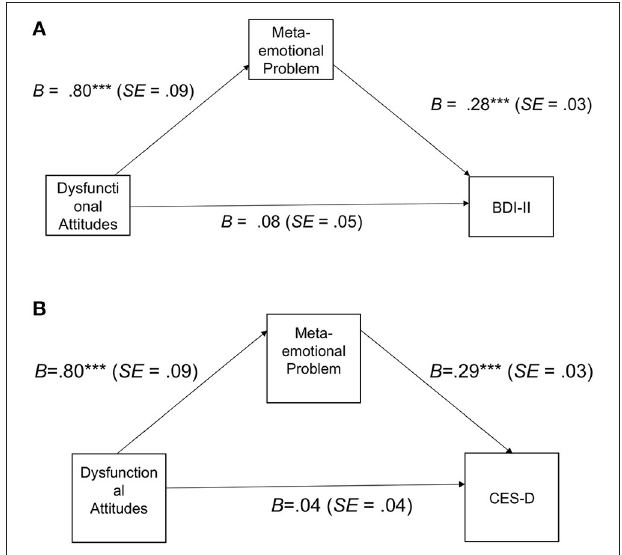
FIGURE 3 | (A) Meditational analysis with BDI-II as dependent variable. (B) Meditational analysis with CES-D as dependent variable.